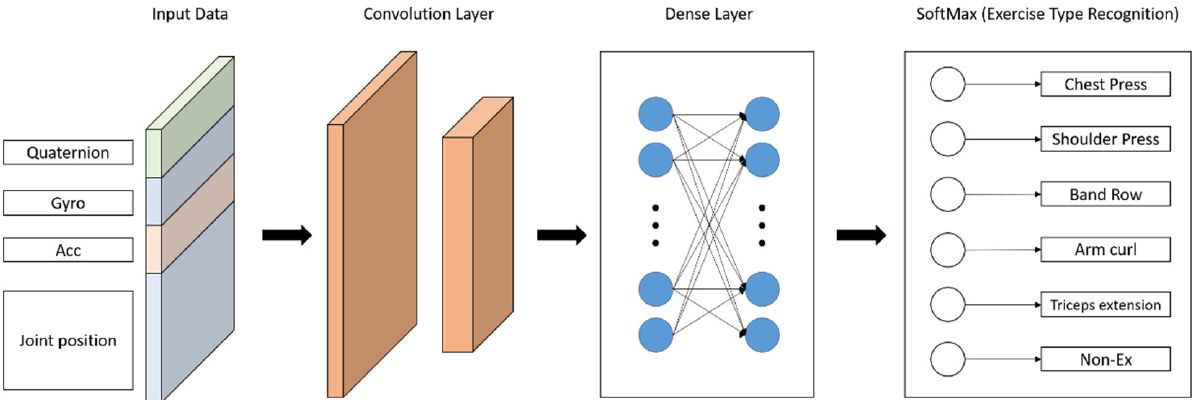
Figure 7. CNN layers. The size of the first convolution layer depends on the input data size. The dense layer is fixed and SoftMax determines the class of the input data.